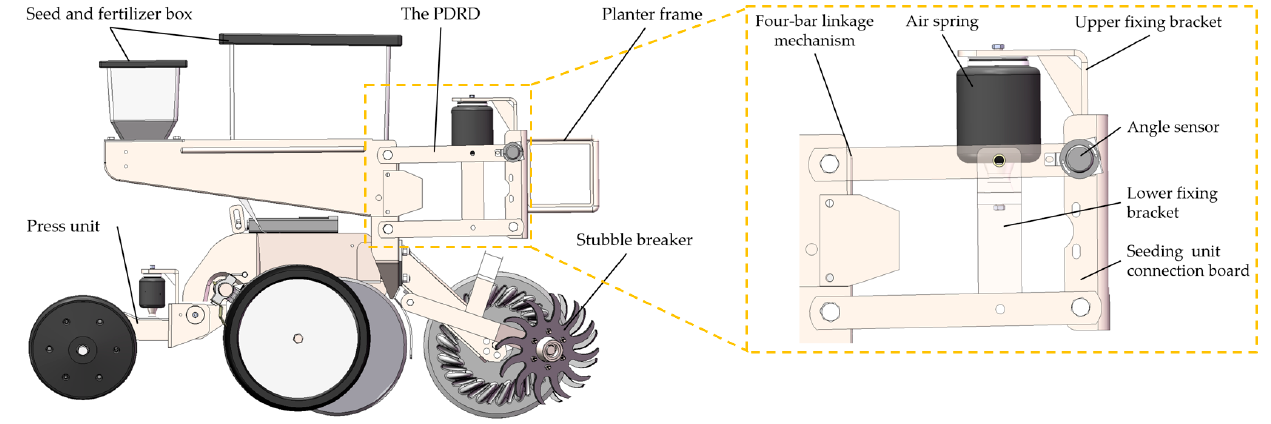
Figure 1. Schematic diagram of the PDRD on the corn no-till planter.